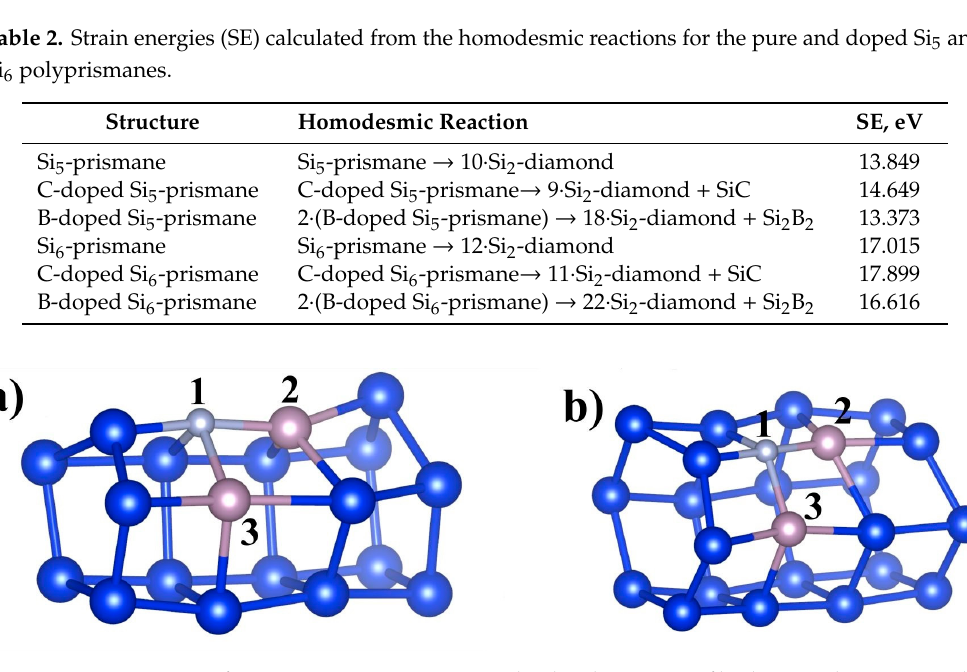
Figure 3. Designations of various atomic positions involved in the process of hydrogen adsorption on the example of doped Si 5 ( a ) and Si 6 ( b ) polyprismanes: 1—impurity atom (C or B), 2 and 3 nonequivalent positions of the silicon atoms (marked in a di ff erent color for clarity). Depicted configurations correspond to the optimized B-doped Si 5 and Si 6 -polyprismanes unit cells. Table 3. Adsorption energies ( E ads ) of the hydrogen atom on the C and B-doped silicon polyprismanes Si 5 and Si 6 depending on the adsorption site (see Figure 3).